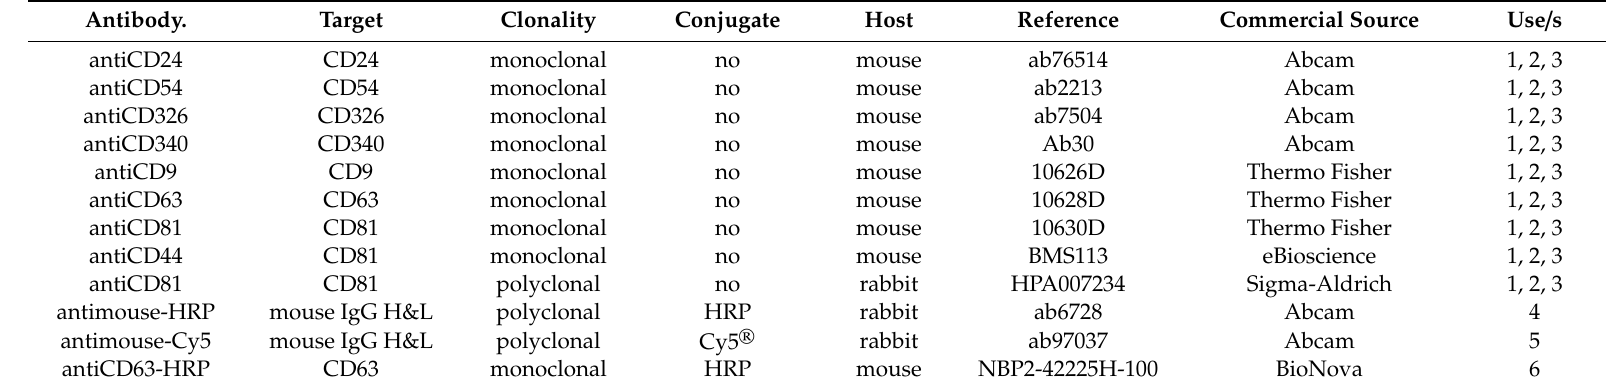
Table 1. Summary of the antibodies used in this work.